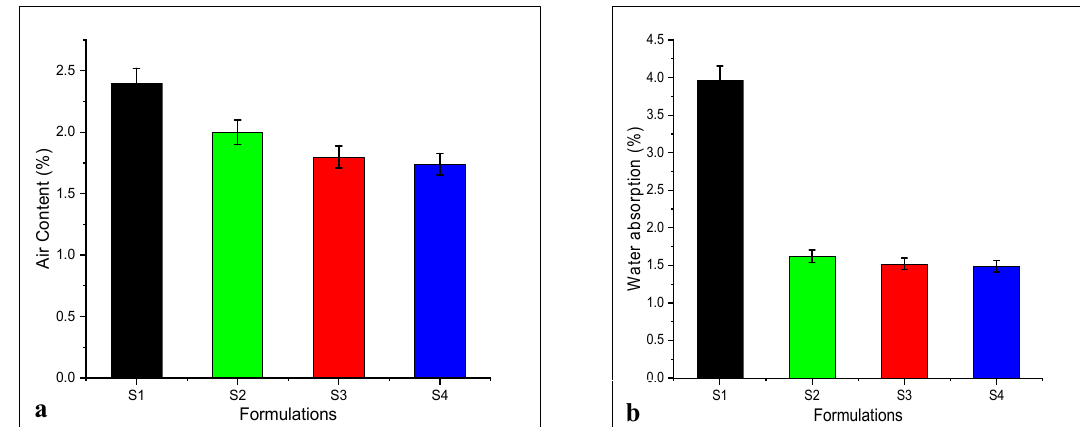
Figure 14. ( a ) Air content of SCCM, ( b ) water absorption of SCCM.